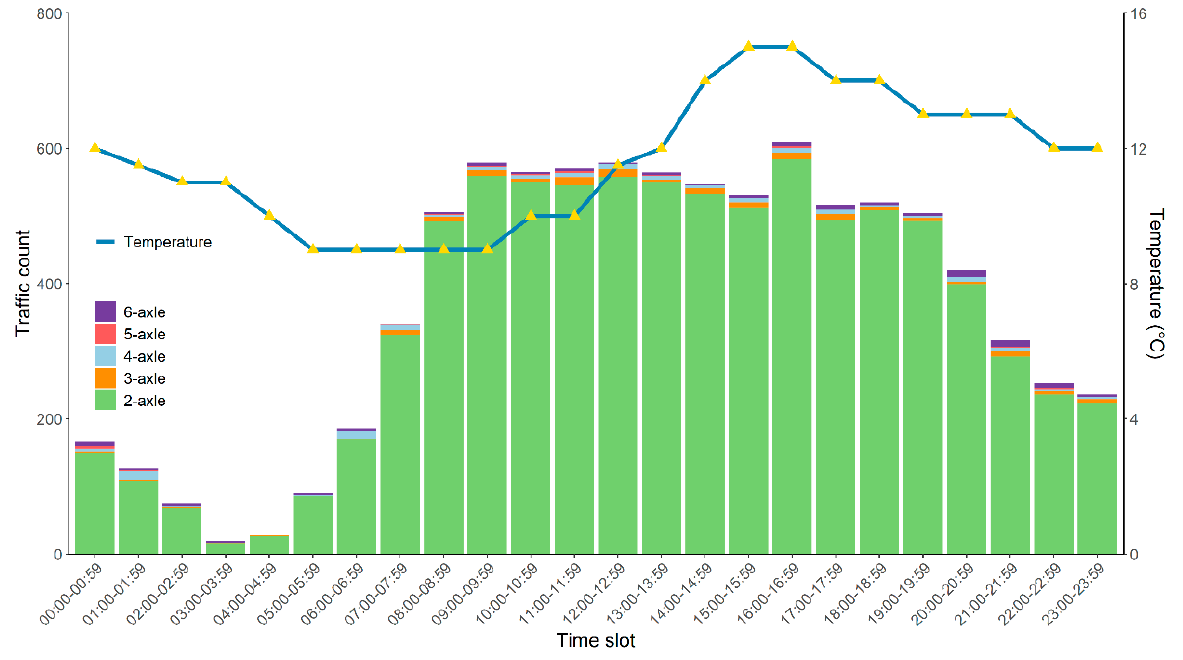
Figure 13. Variation in traffic count and temperature over hours.